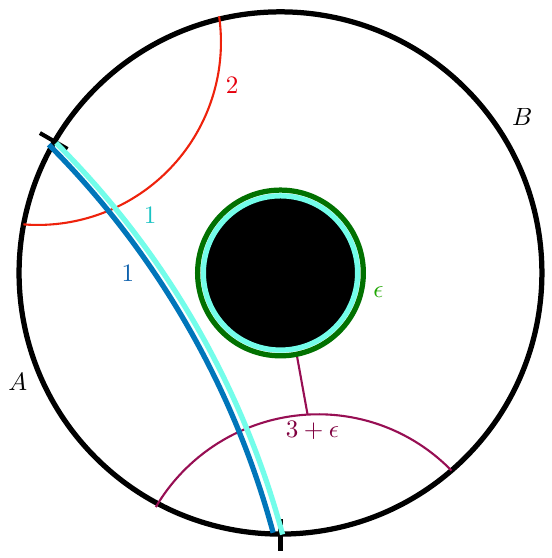
Figure 8 . The minimal barrier configuration of (3.15) for the black hole state is given by m A ∪ m B which includes the black hole horizon. Since the 3-threads must connect to horizon which is finite this surface acts the limiting factor for their contribution. As such the maximal hyperthread configuration includes a number of 3-threads up to thermal entropy along with additional 2-threads connecting A to B . The barrier configuration excludes 2-threads connecting either A or B to the horizon.